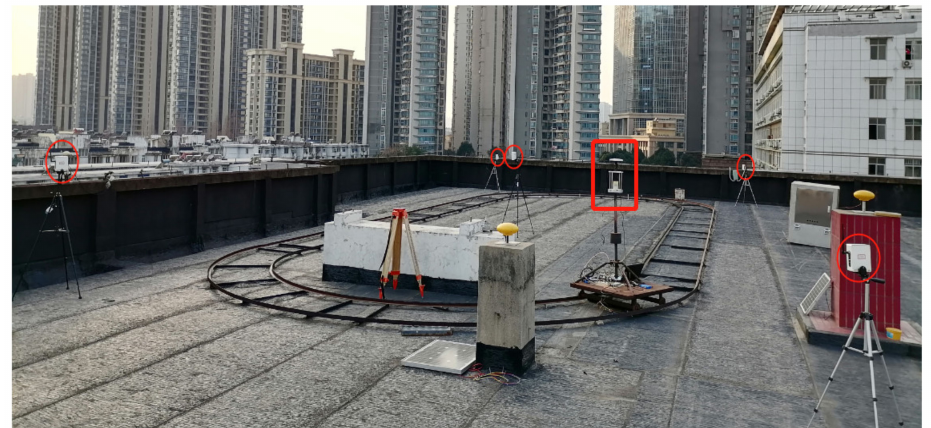
Figure 5. GNSS RTK/UWB/DBA fusion dynamic cart positioning experiment site (UWB BSs are in the red round box, and the GNSS antenna, UWB Tag, and BMP280 barometer combined device are in the red rectangular